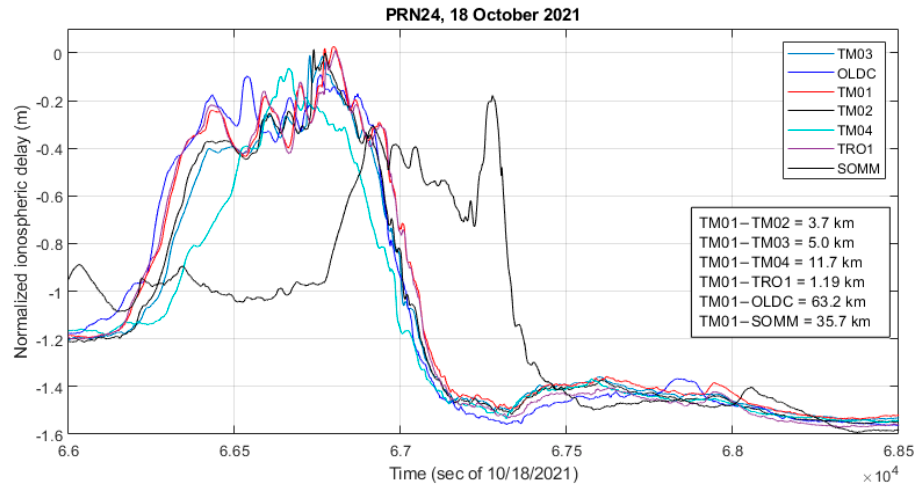
Figure 5. Variation in the slant ionospheric delay as observed on GPS PRN24 by a subset of monitoring stations. Elevation angle of 48°–60° across stations during the plotted time period. Estimated propagation speed over ground of 155 m/s.